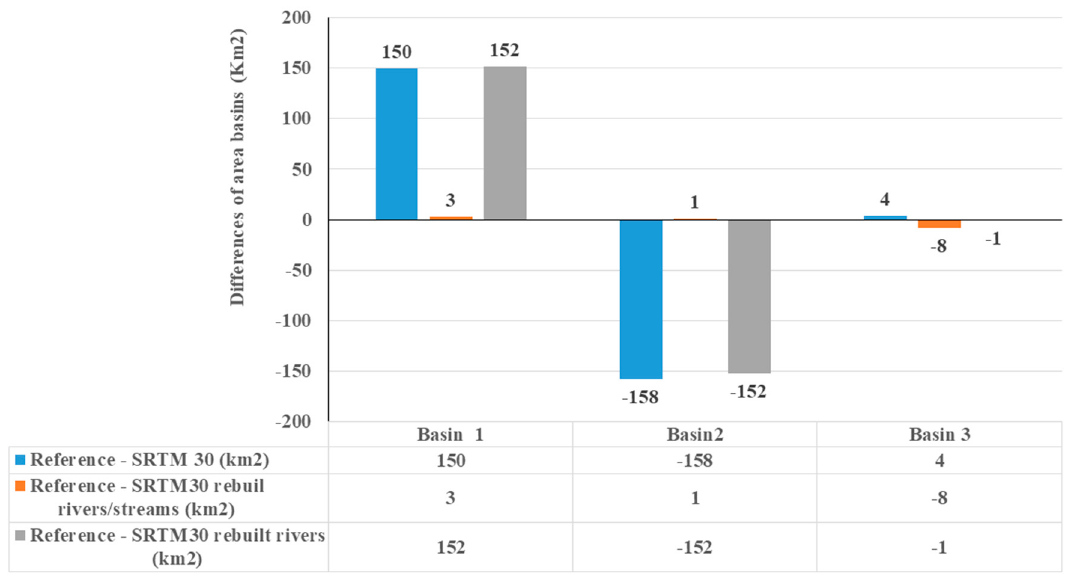
Figure 26. Graph showing the area differences between the basins obtained from the reference DEM and the ones obtained from SRTM 30 and the rebuilt DEMs (the SRTM 30 DEM rebuilt with OSM rivers and streams and the SRTM 30 rebuilt with OSM rivers).